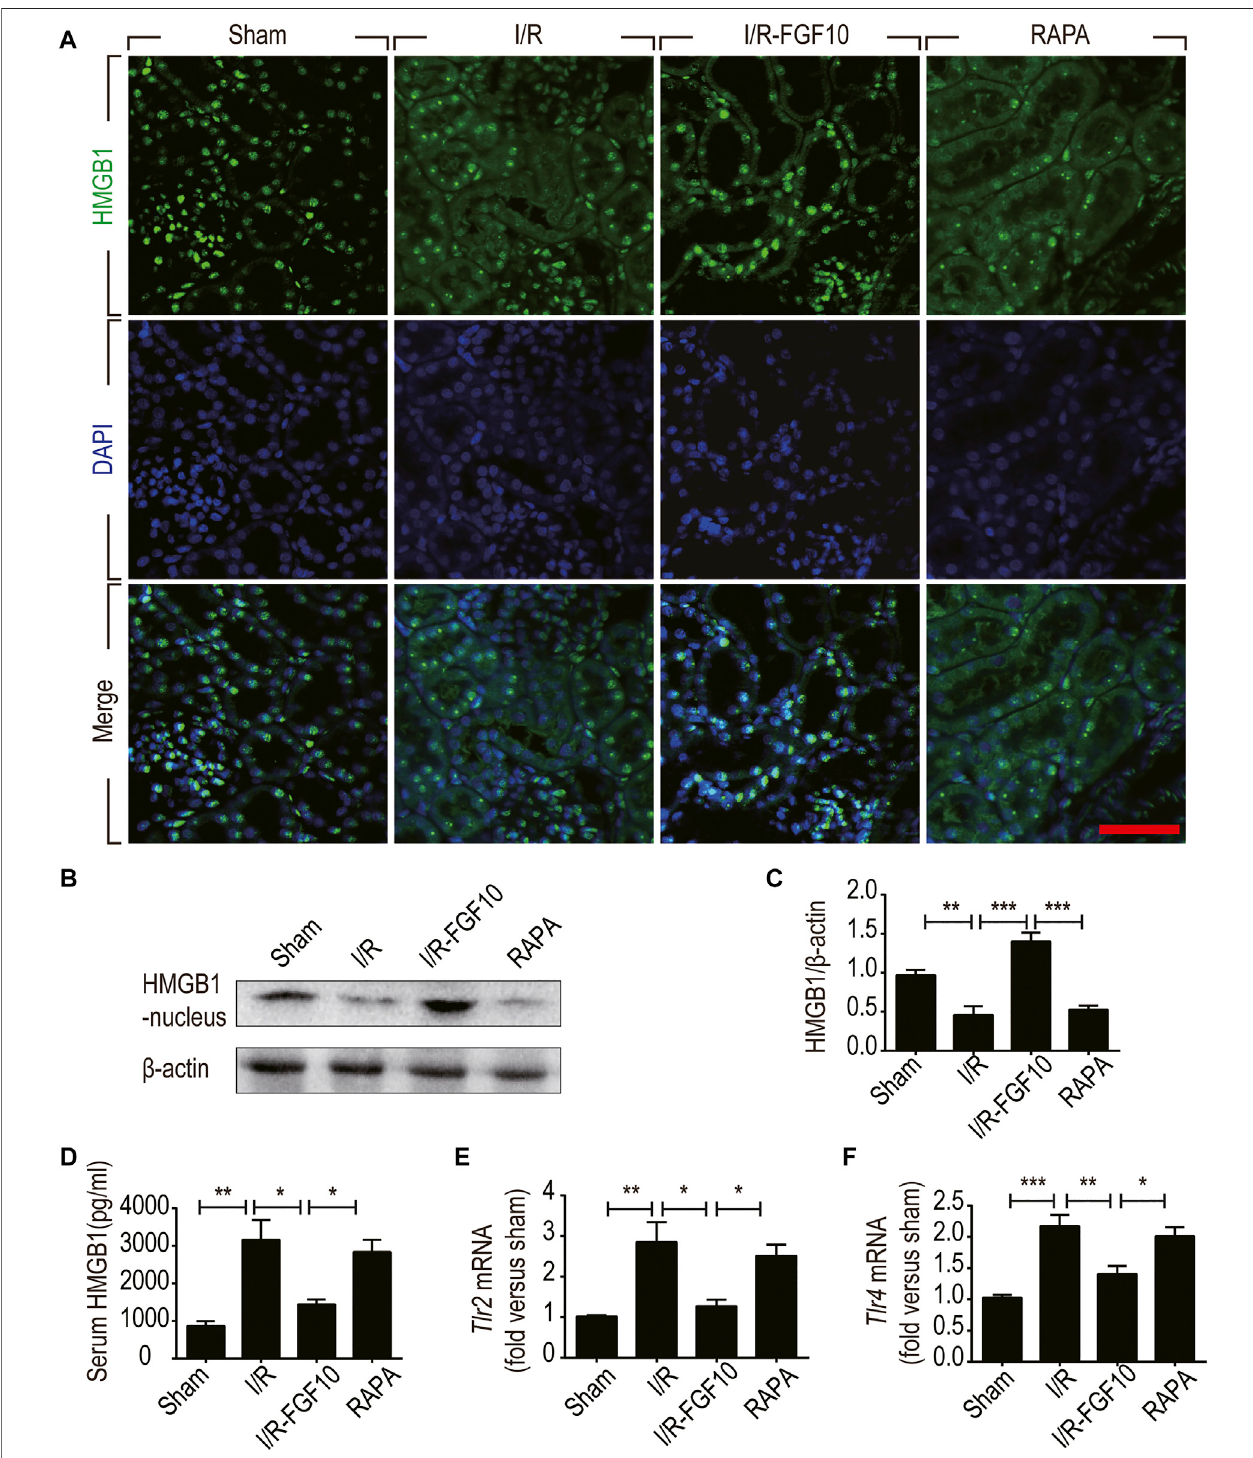
FIGURE 7 | FGF10 inhibits the release of nuclear HMGB1 to the serum and regulates the TLR mRNA expression. (A) Immuno fl uorescence staining of HMGB1 at 2 days after reperfusion. Nuclei were labeled with DAPI (blue). Scale bars (cid:1) 50 m. (B,C) Protein expression of HMGB1 in the nuclear fraction of renal tissues by Western blot and optical density analysis with β -actin as loading control (mean ± SEM; n (cid:1) 5). pp p < 0.01, ppp p < 0.001. (D) Level of serum HMGB1 was determined by ELISA (mean ± SEM; n (cid:1) 5). p p < 0.05, pp p < 0.01. (E,F) ExpressionofTlr2andTlr4mRNAinthekidneywereexaminedbyRT-qPCRandnormalized toGapdh. p p < 0.05, pp p < 0.01, ppp p < 0.001.